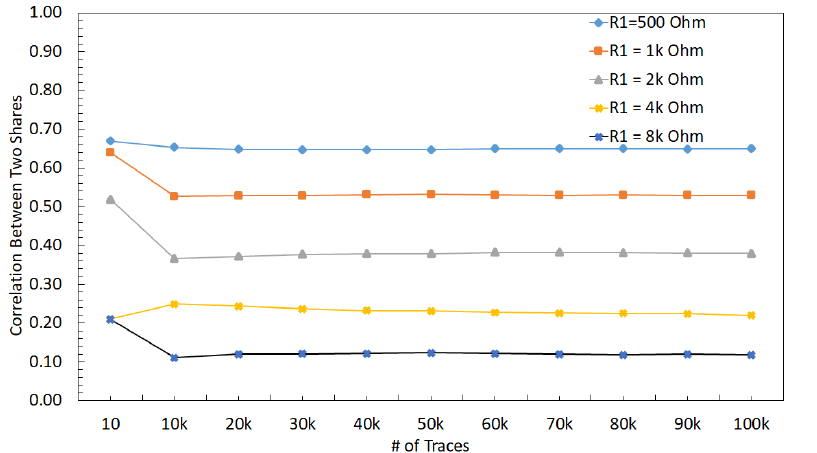
Figure 18. Correlation between V 1 and V 2 when R1 is changed from 500 Ω to 8 k Ω when a weak (smaller) DLDO is used as the voltage